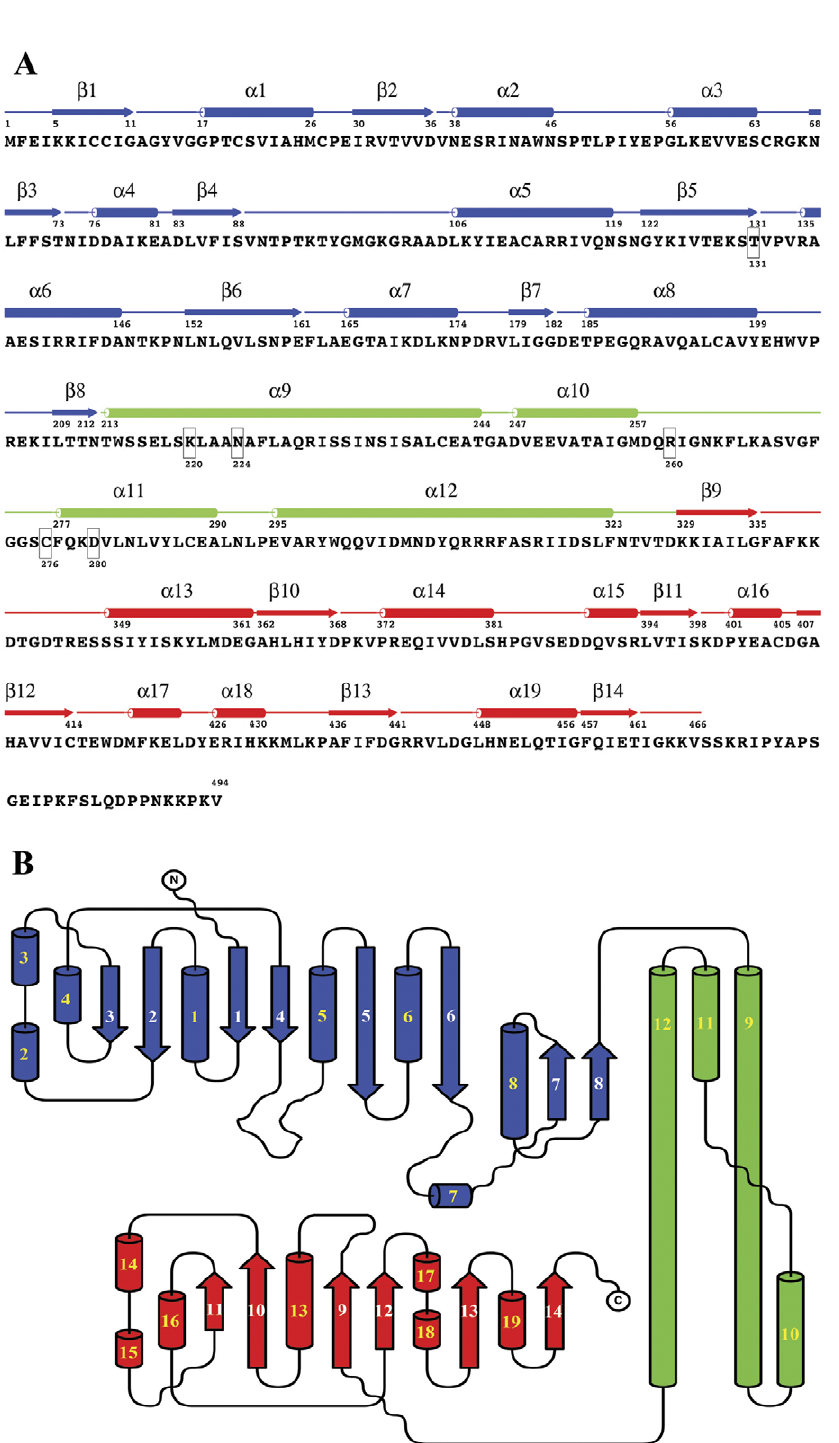
Figure 3. Secondary structure and topology of the hUGDH protomer. (A) Secondary structure elements shown above the hUGDH amino acid sequence in domain colors (N-terminal, blue; central, green; C-terminal, red). Important active site residues are boxed. (B) Topology of the protomer. The figures were generated in ALSCRIPT [49] and TOPDRAW [50].